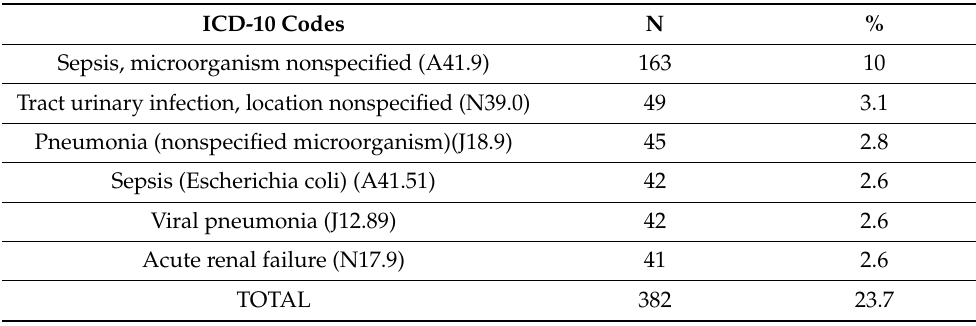
Table 7. Most frequent main causes of hospitalization in deceased patients when kidney or ureteral lithiasis were coded as main diagnosis or